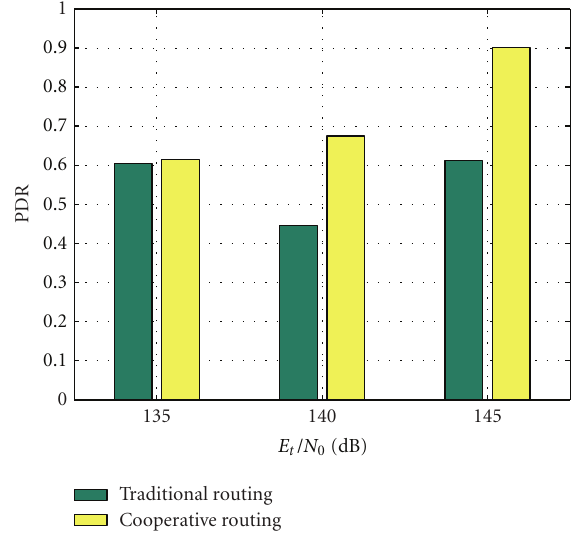
Figure 8: Traditional routing versus cooperative routing